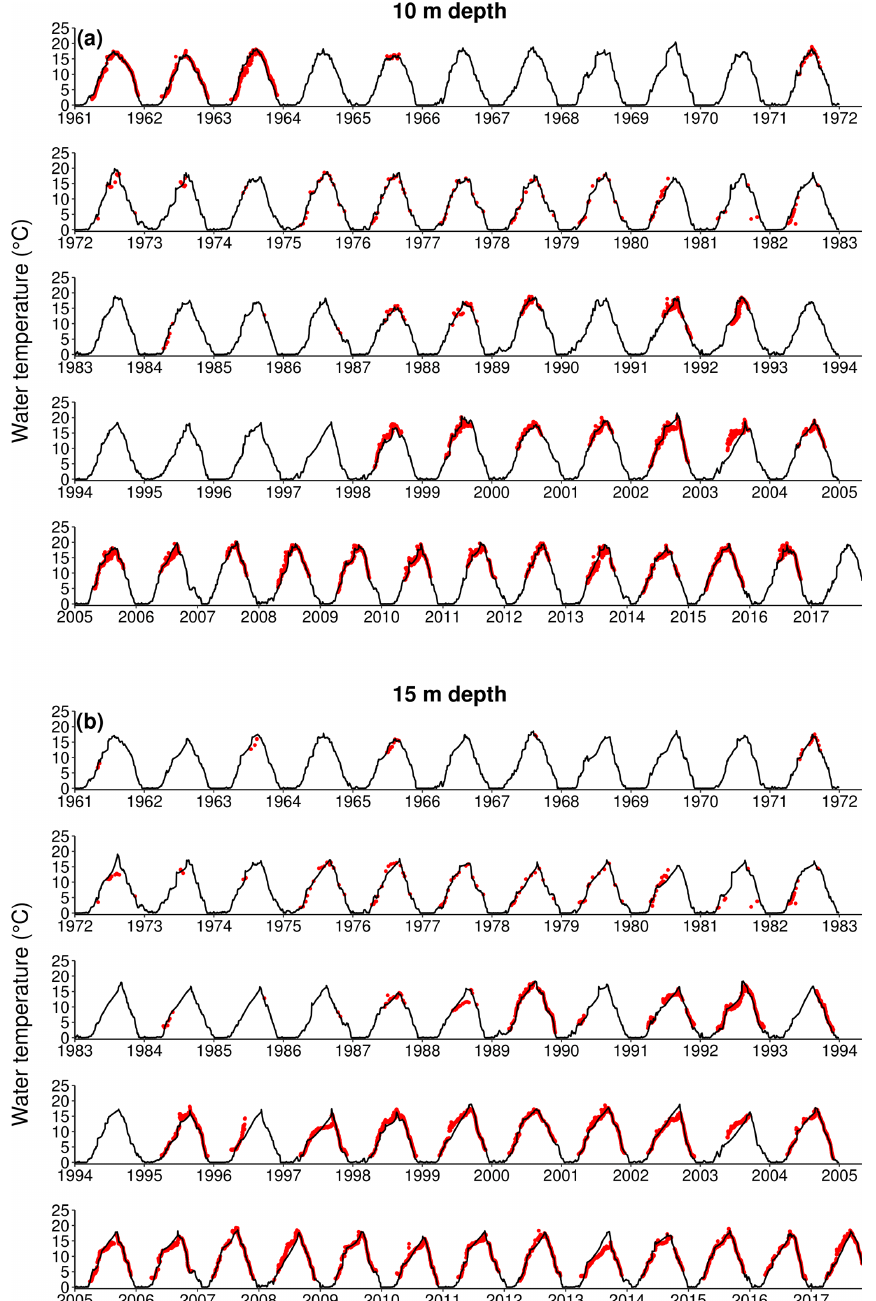
Figure 4. Comparison between Erken modelled (black line) and observed daily temperature (red dots) at 10m (a) and 15m (b) depth (10m depth: RMSE = 1.187 ◦ C, MAE = 0.811 ◦ C, bias = 0.003 ◦ C; 15m depth: RMSE = 1.155 ◦ C, MAE = 0.803 ◦ C, bias =− 0 . 137 ◦